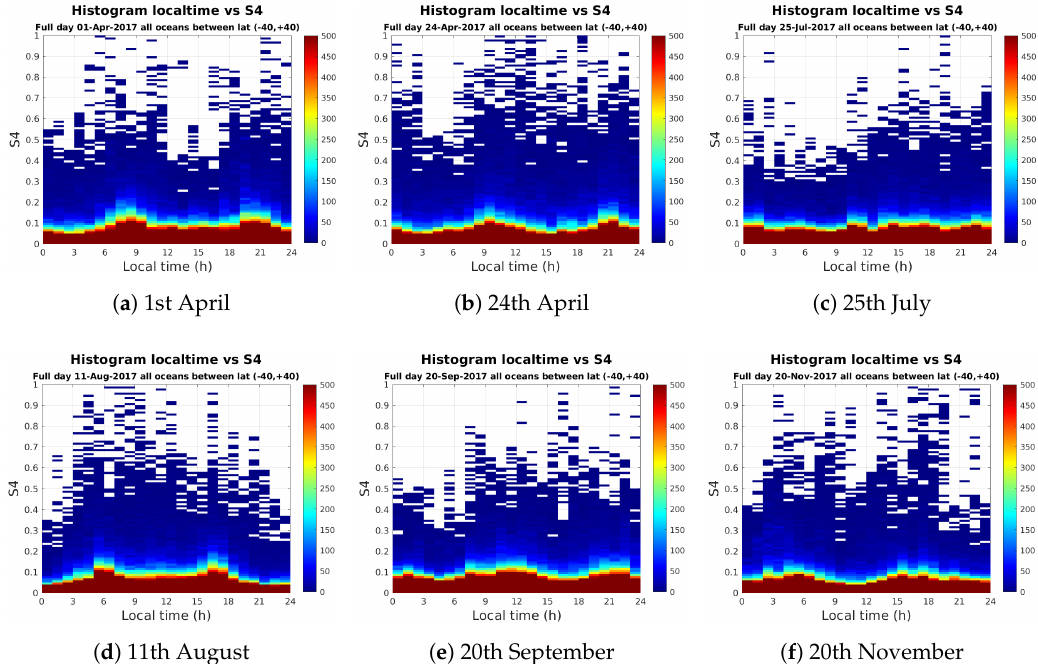
Figure 18. Histogram count of specular reflection points over all oceans between 40 ◦ N and 40 ◦ S for each S 4 value and LT hour, from 0 h to 24 h (UTC) during selected days in